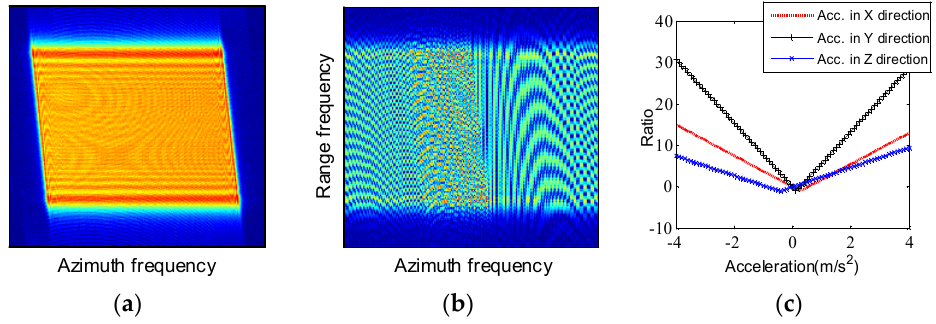
Figure 7. Two-dimensional spectrum of Conv-SAR and CF-SAR [16]. ( a ) Conv-SAR. ( b ) CF-SAR. ( c ) Ratio of azimuth bandwidth spreading versus acceleration.